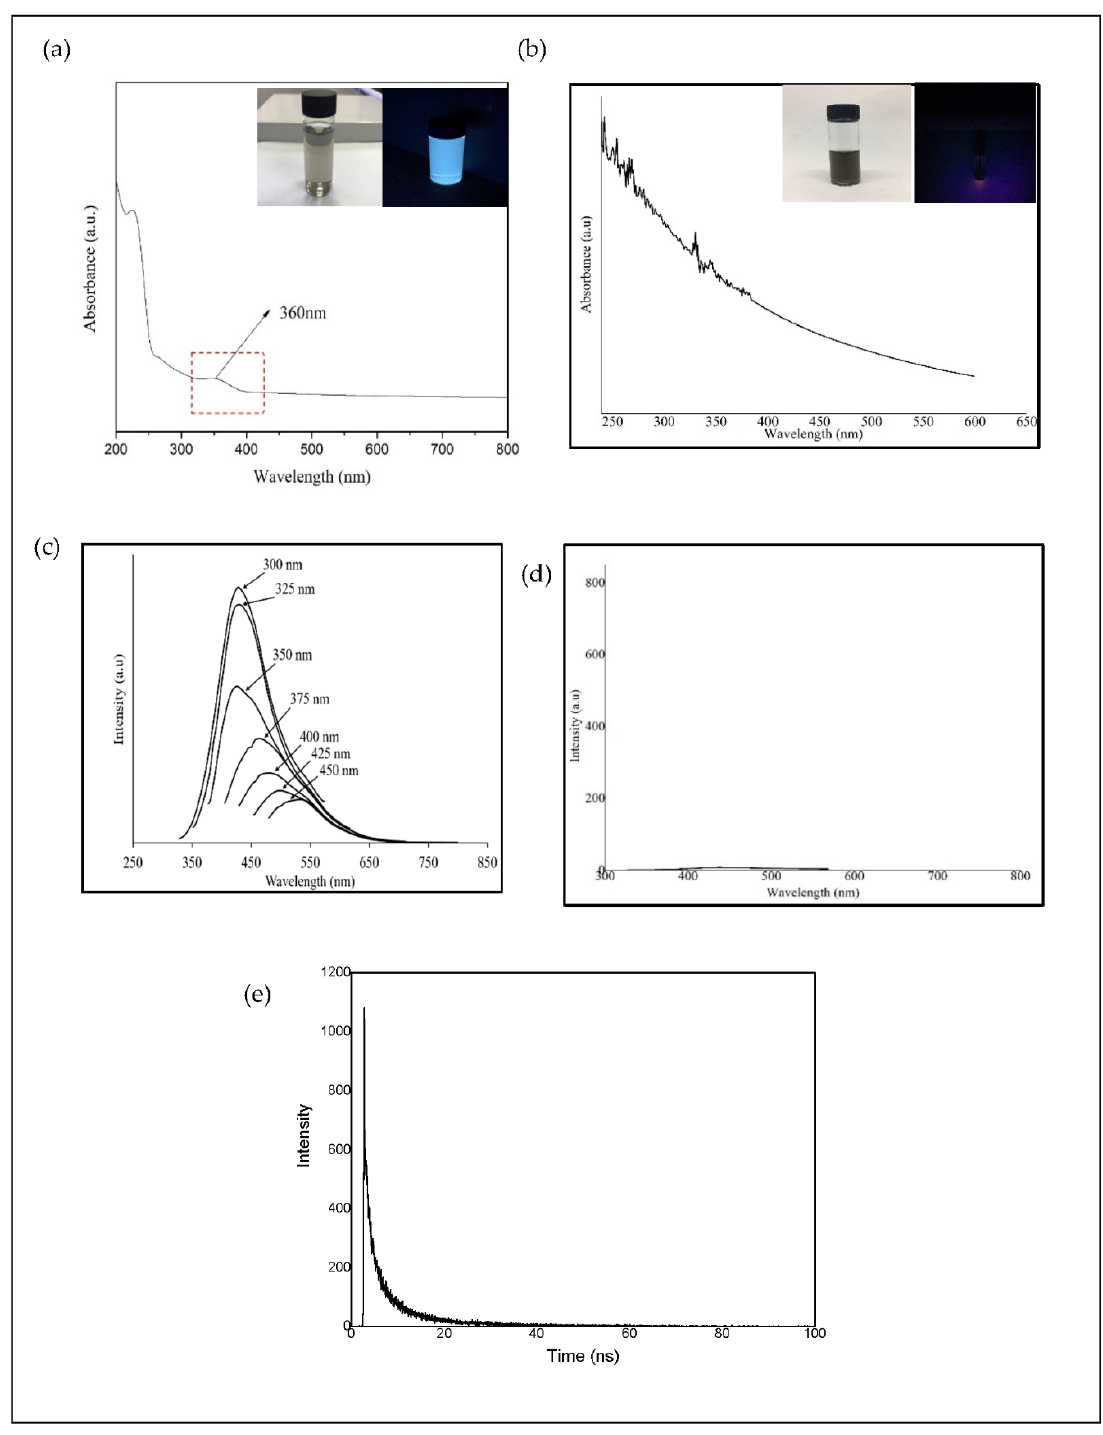
Figure 2. Optical spectra of supernatant obtained from ( a ) CQD and ( b ) EFB biochar (inset: images of supernatant under daylight and 365 nm ultraviolet (UV) light source); PL spectrum of ( c ) CQD at different excitation wavelengths (300–450 nm), ( d ) EFB biochar at excitation 300 nm and ( e ) fluorescence life time of CQD.